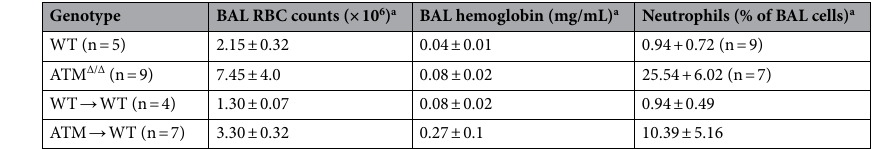
Table 1. BAL RBC counts and hemoglobin levels in bleomycin-instilled animals. a Mean ± SEM.